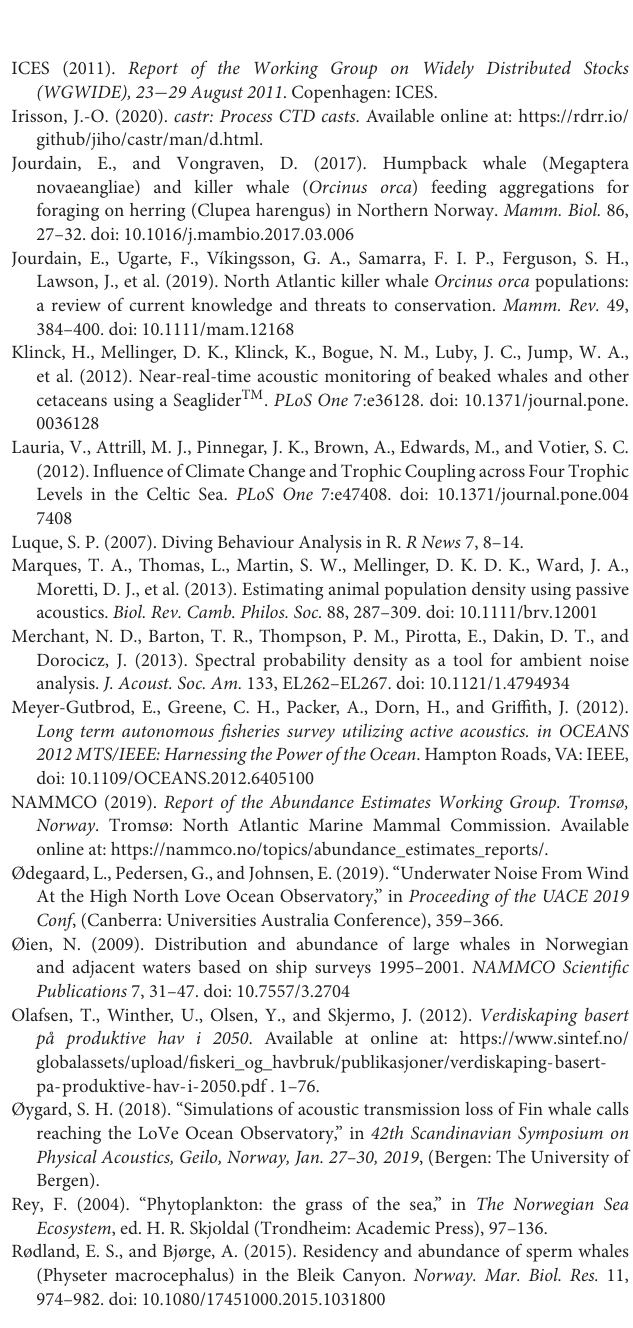
Supplementary Table 5 | SPL glmmTMB model Humpback Whales. Supplementary Table 6 | SPL glmmTMB model Fin whales. Supplementary Table 7 | SPL glmmTMB model Sperm whales. Supplementary Table 8 | SPL glmmTMB model